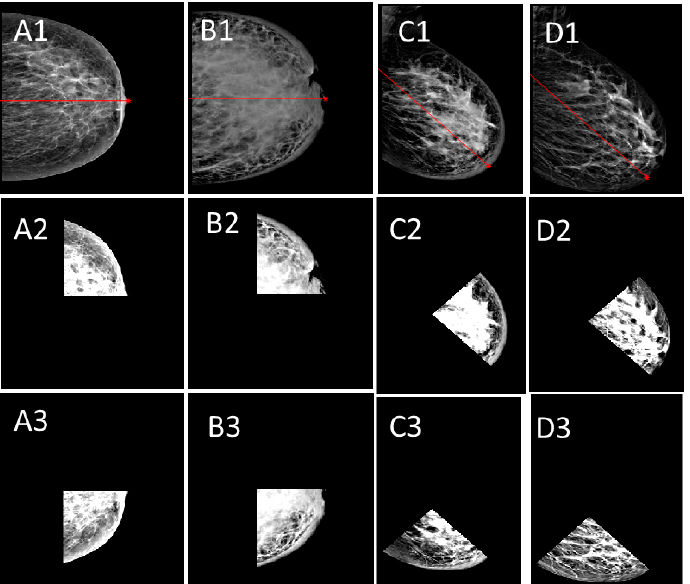
Figure 2. Identification of the entire breast, the view of the image as MLO or CC, and nipple location. The nipple location algorithm runs based on the view of the mammogram. The MLO and CC views, their nipple location, and data augmentation are shown. The red line is placed by an automatic nipple location algorithm, it divides the breast in half as the nipple location being the reference point. ( A1–A3 , B1–B3 ) show the segmentation of the quarters from CC views while ( C1– C3 , D1–D3 ) show the segmented quarters from MLO views.